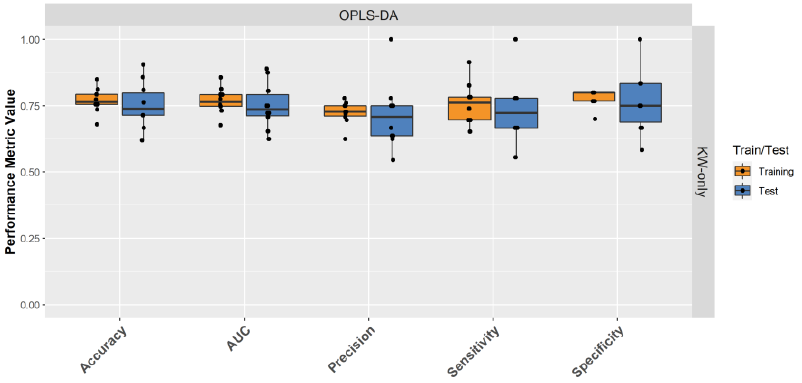
Figure 4. Cross-validation performance of champion machine learning algorithm for LRRK2 PD classification. The data with KW-only and “Known + Unknown” features was split 70/30 into training and test data, 10 × cross-validated using an OPLS-DA model.